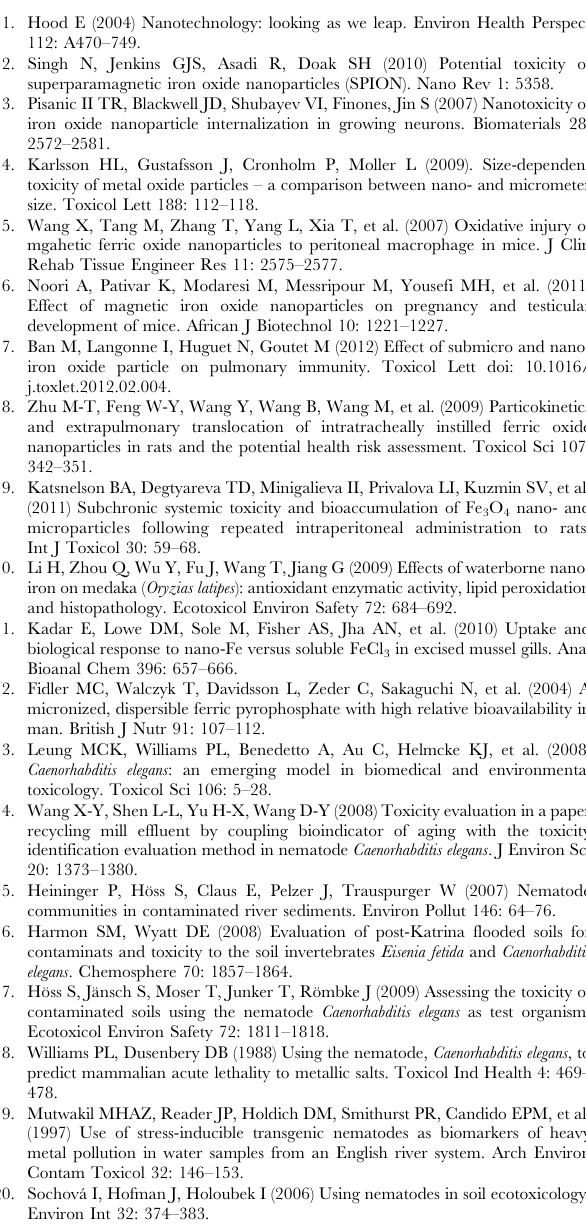
Table S2 Physicochemical properties of Fe 2 O 3 -nano- particles.